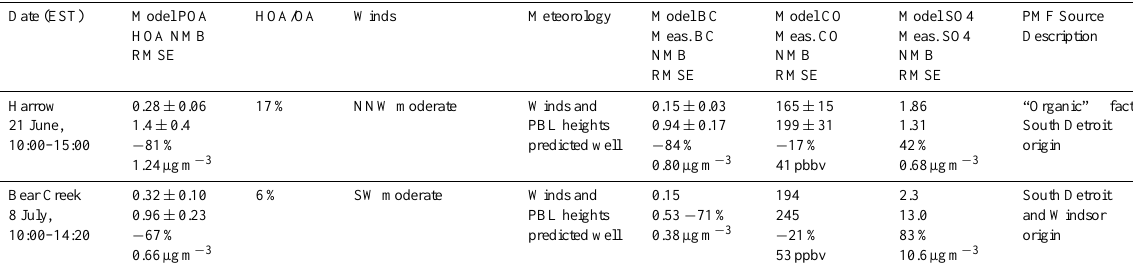
Table 10. Detroit-Windsor urban-influenced air masses arriving at Harrow and Bear